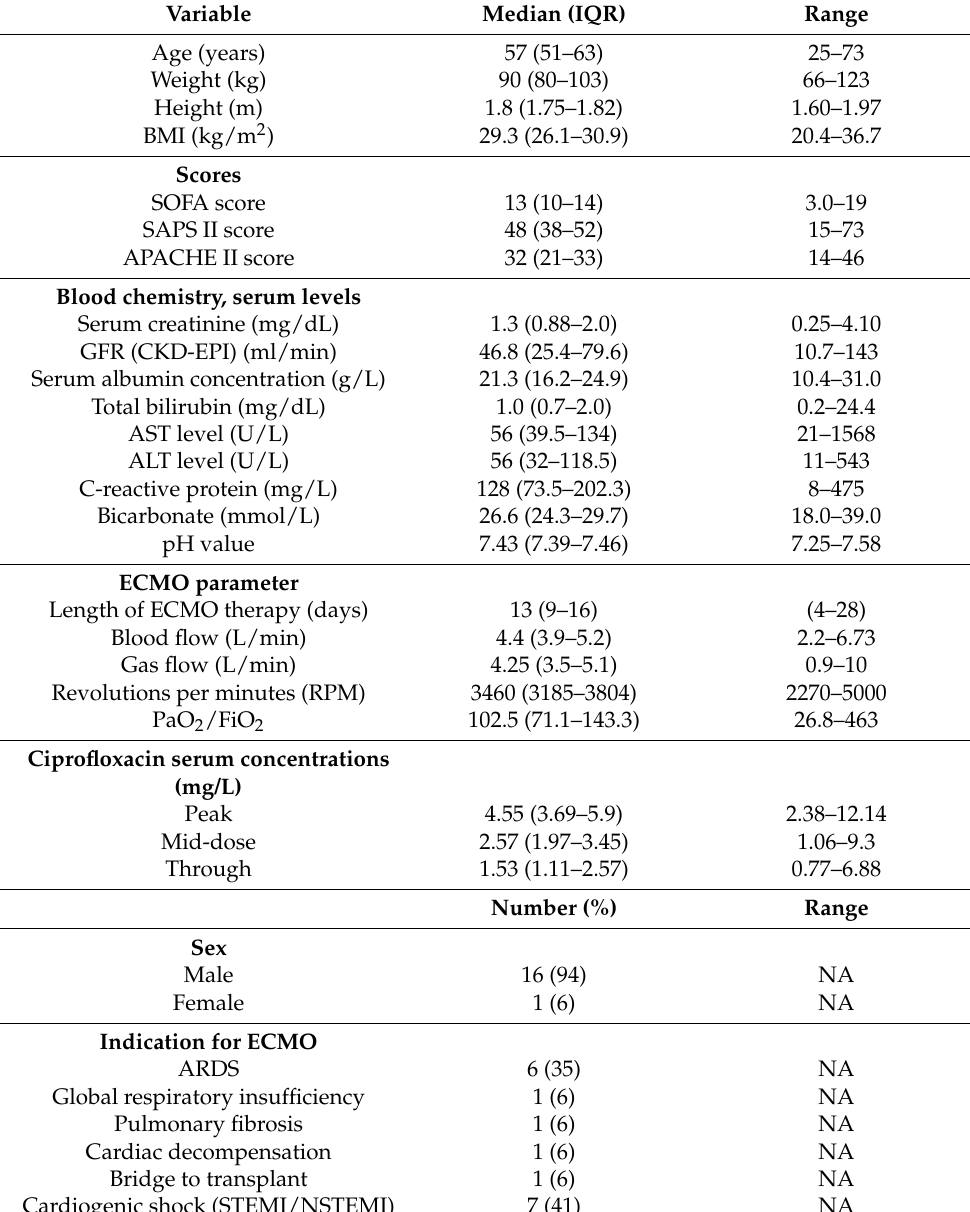
Table 1. The demographic and clinical